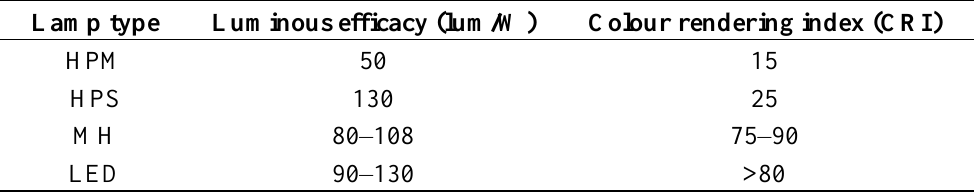
Table 3. Main features of the different kind of